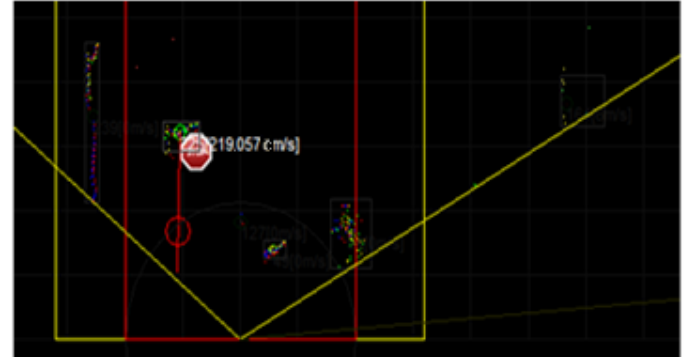
Figure 9. There is an object in the danger zone and collision is highly probable. A stop sign appears on the screen, an alarm signal plays and automatic brakes are activated. Heading of the object can be seen with a red line and possible collision position can be seen with the red circle.